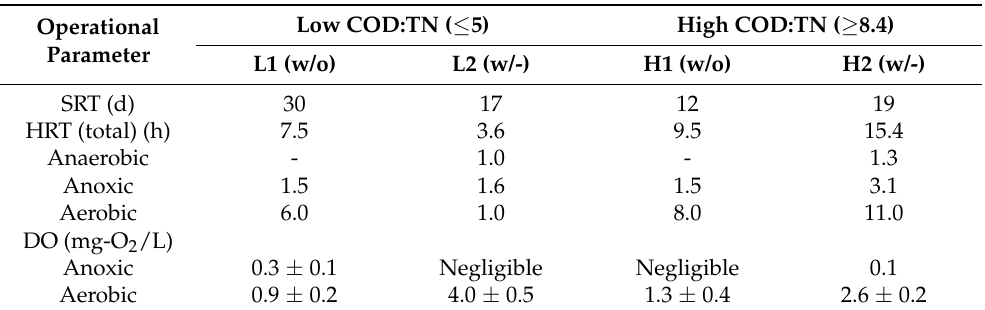
Table 1. Operational parameters of the full-scale pre-anoxic zone w/- and w/o anaerobic systems by low and high COD:TN